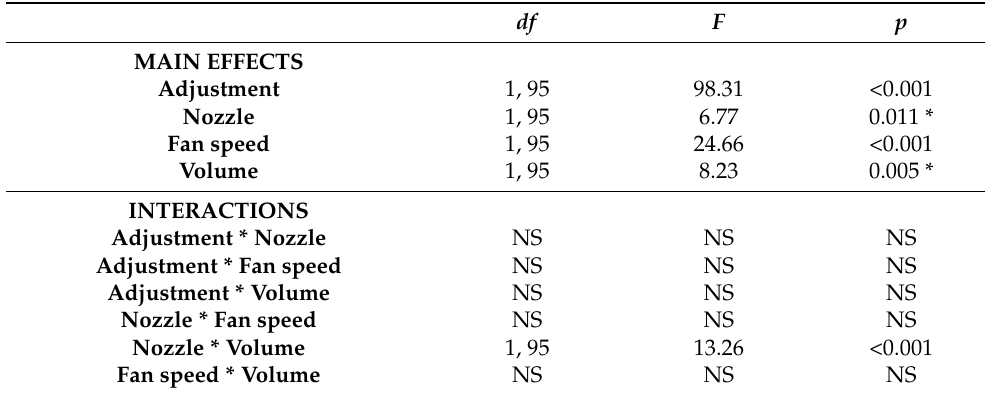
Table 7. Two-way ANOVA results for the normalized volume collected in the canopy zone with the C1 sprayer (least significant difference (LSD) test, p < 0.05) a